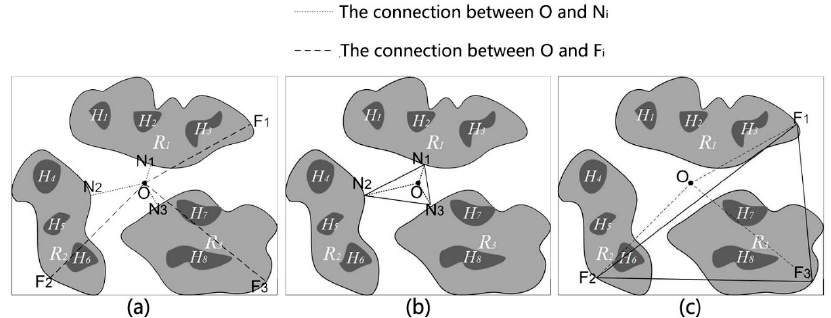
Figure 3. ( a ) Selection of the nearest points and farthest points; ( b ) nearest points position graph (NPPG); ( c ) farthest points position graph (FPPG).